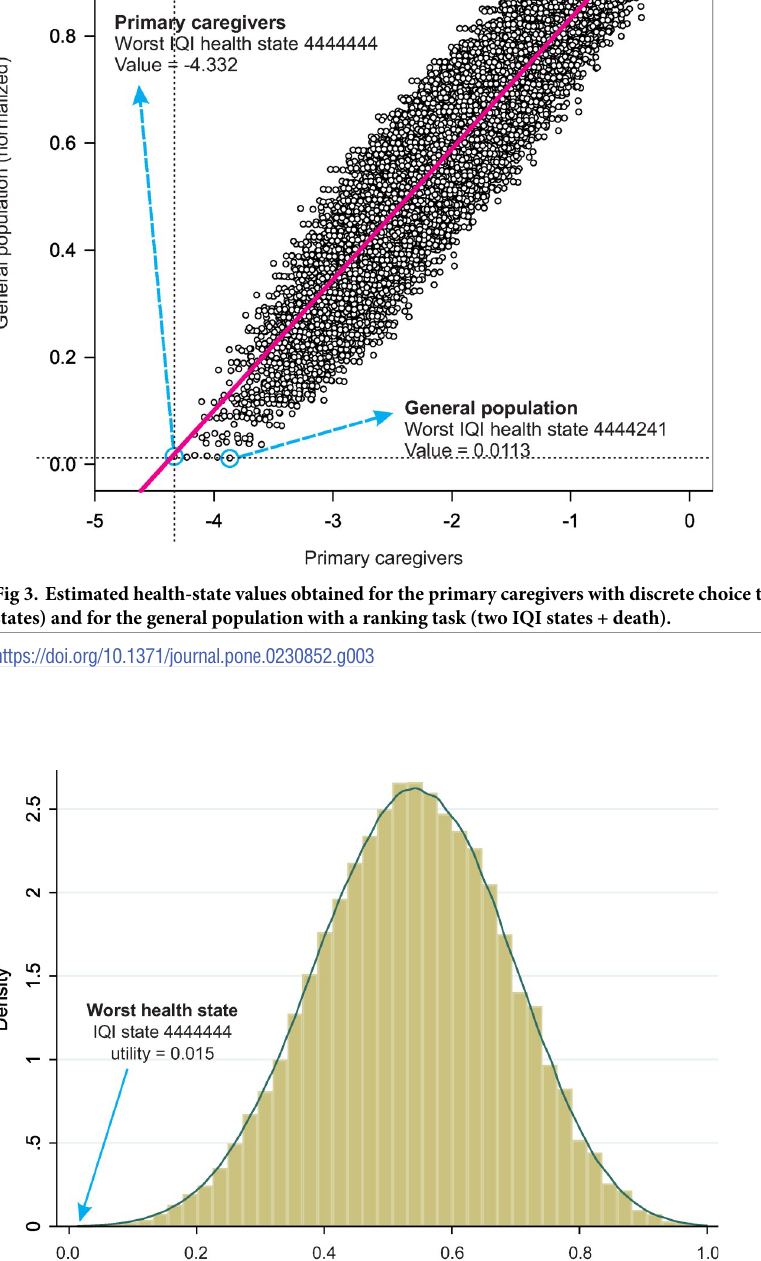
PLOS ONE | https://doi.org/10.1371/journal.pone.0230852 April 3,